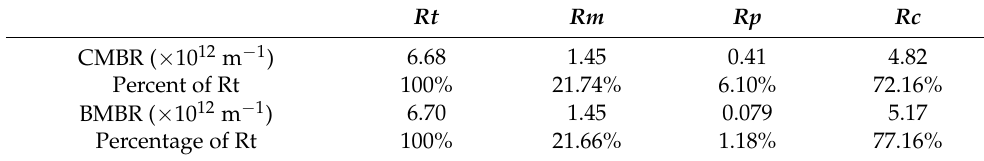
Table 3. Membrane filtration resistance in conventional MBR (CMBR) and biochar MBR (BMBR).